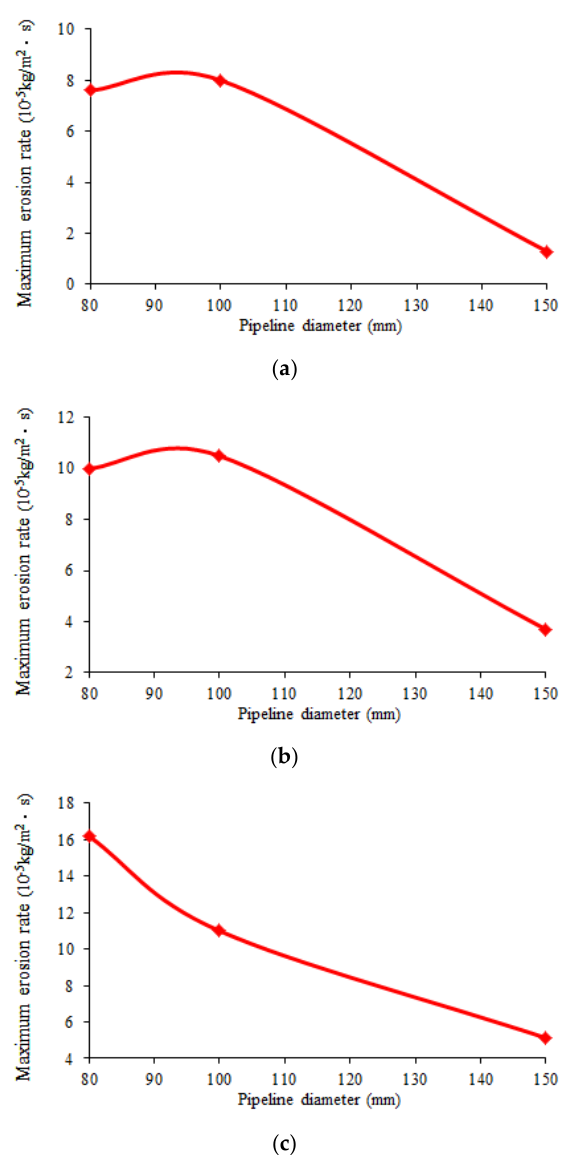
Figure 15. Curves of the maximum erosion rate versus pipe diameter. ( a ) 20% of the throttle valve opening (C = 20%); ( b ) 30% of the throttle valve opening (C = 30%); ( c ) 50% of the throttle valve opening (C = 50%).